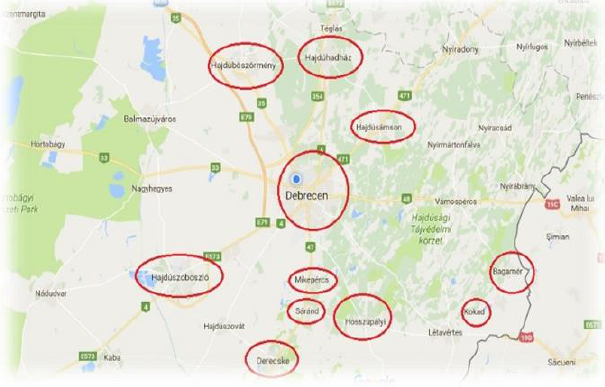
Figure 6. CALLSITE-s of the work (I-1)